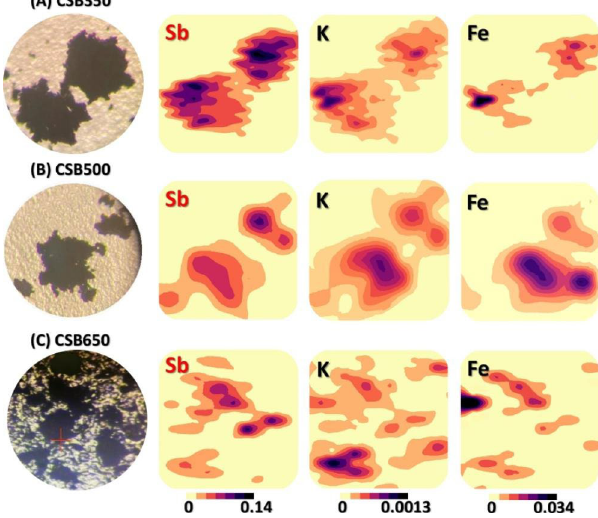
Fig. 5 The microscope photos and µ-XRF maps of Sb, K, and Fe dis- tribution within Sb-laden CSB350, CSB500, and CSB650 particles. CSB350, CSB500, and CSB650 indicate the crawfish shell biochar pyrolyzed at 350 ° C, 500 ° C, and 650 ° C, respectively. Higher fluores- cence intensities indicate higher concentrations of